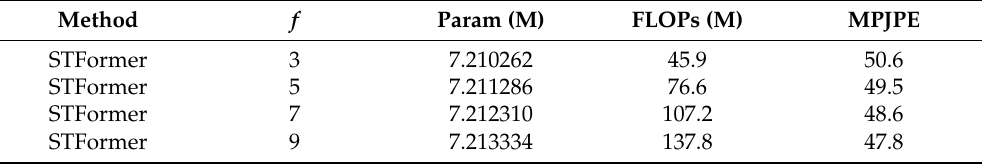
Table 3. Results of ablation experiments with STFormer at different input frames.